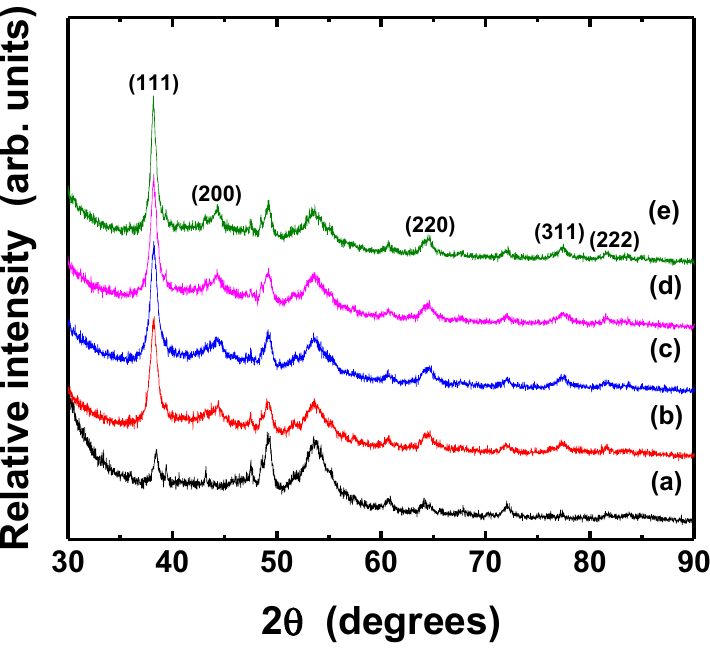
Figure 8. XRD patterns of Ag thin films thermally treated at different temperatures: ( a ) PET substrate, ( b ) as-deposited, ( c ) 90 °C, ( d ) 120 °C, ( e ) 150 °C, respectively. The pot-treatment duration was 10 min.